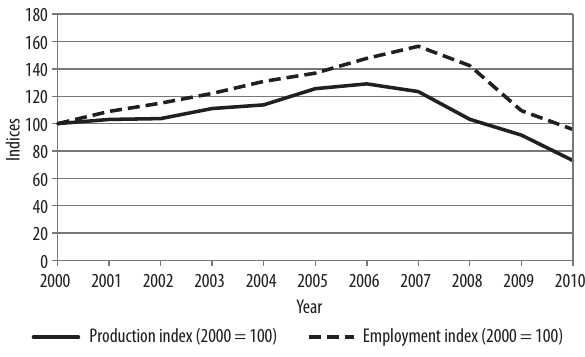
Fig. 1. Production and employment